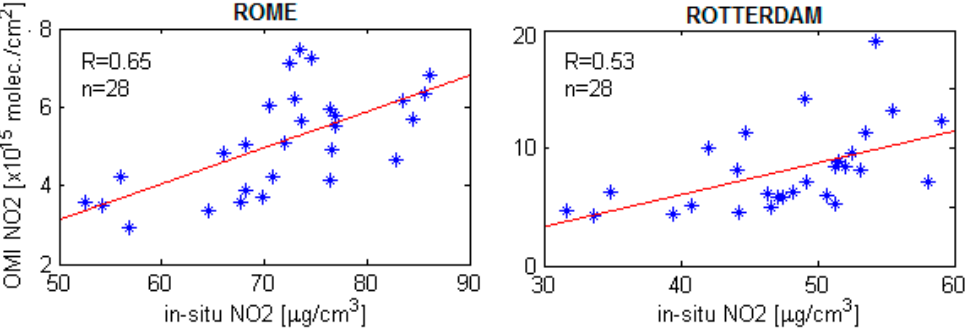
Figure 3. Correlations between the seasonal variation of tropospheric NO 2 VCD observed by OMI and in ‐ situ NO 2 recorded at the monitoring traffic stations during 2005–2011.